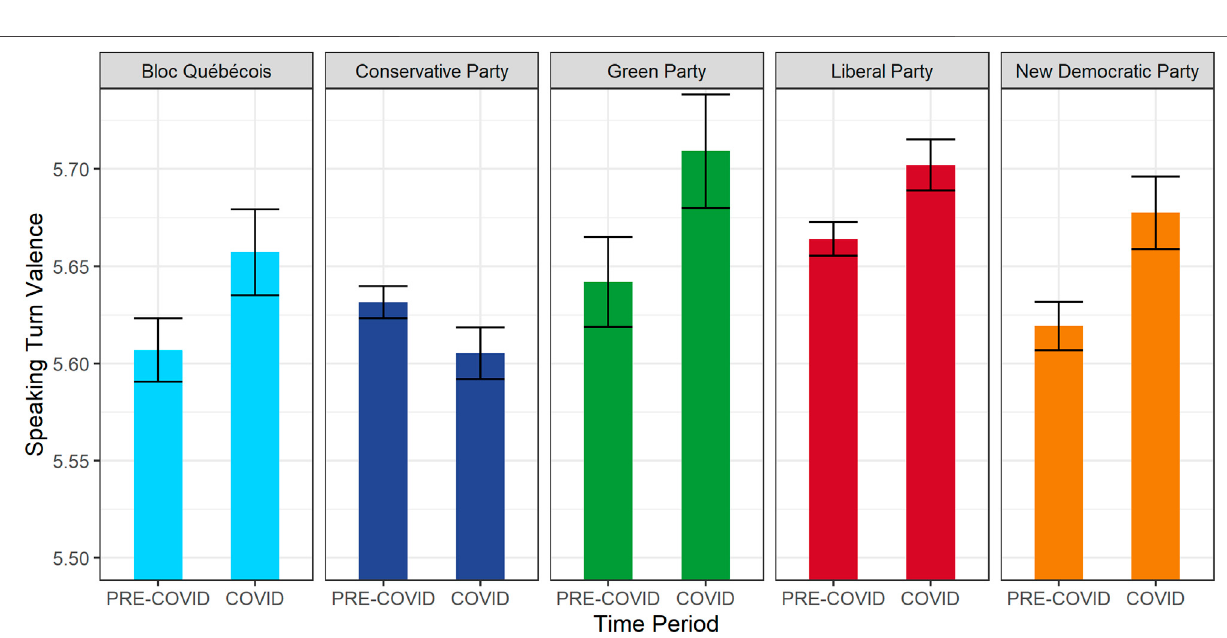
Frontiers in Communication |